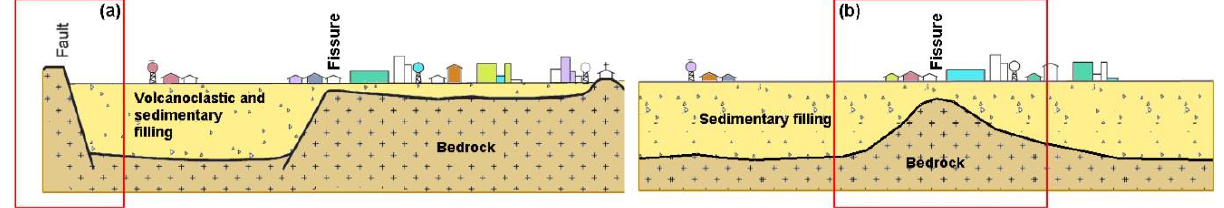
Figure 1. Sketches of the typical geological setting ground rupture in Queretaro City (a) and Wuxi, China (b) . The simulated configurations are highlighted by the red boxes.